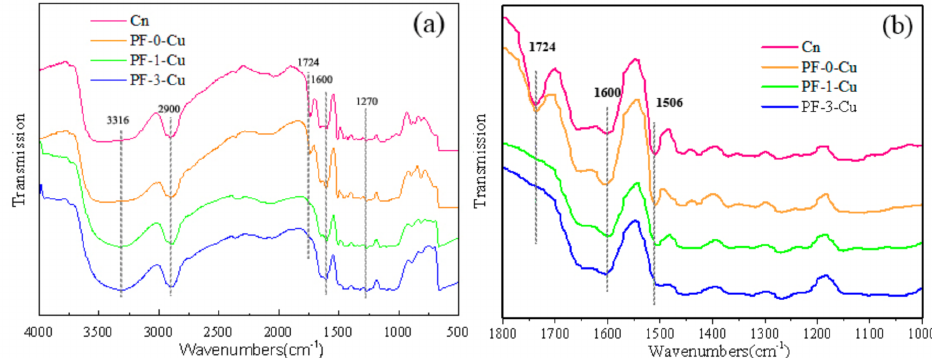
Figure 9. FTIR spectra of the control ( a ), PF-0-Cu, PF-1-Cu, and PF-3-Cu samples ( b ). Table 5. FTIR spectrum assignments of the control, PF-0-Cu, PF-1-Cu, and PF-3-Cu samples. Wavenumbers (cm − 1 ) Assignment